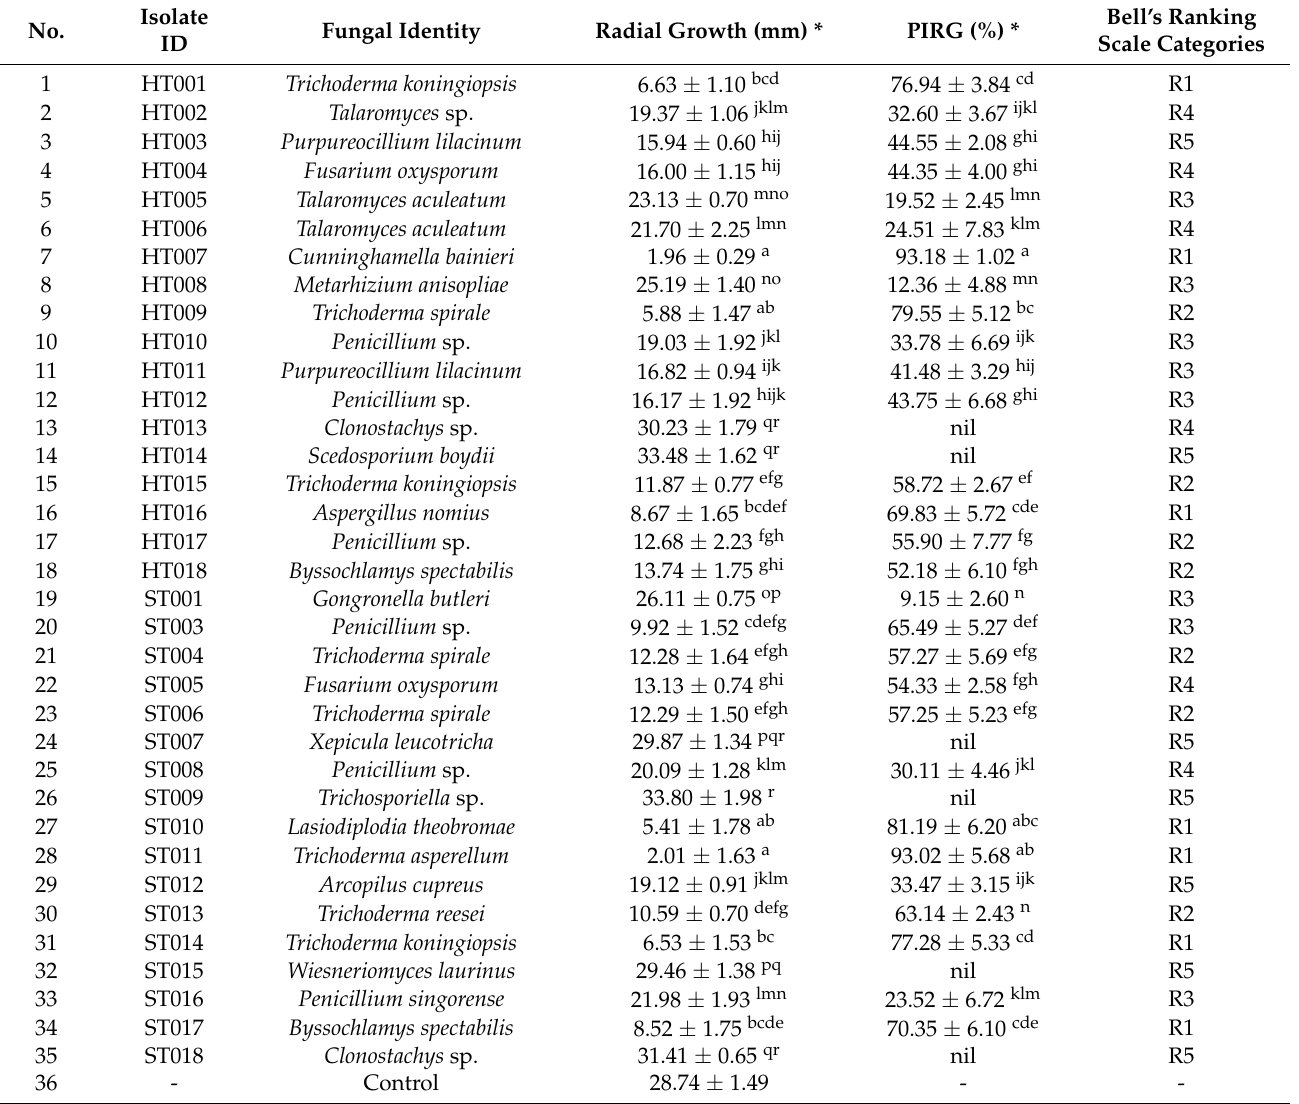
Table 4. Effects of 35 isolates of soil-borne fungi in a dual culture assay on Rigidoporus microporus radial growth, percentage inhibition of radial growth (PIRG), and Bell’s ranking scale [26] categories after 5 days of culture in Petri dishes with the potato dextrose